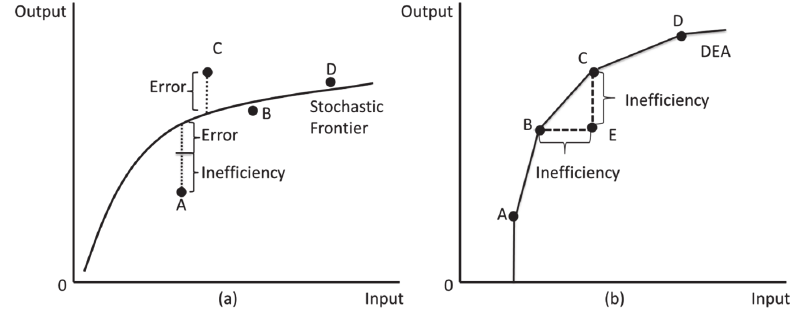
Fig. 2. SFA Frontier and DEA